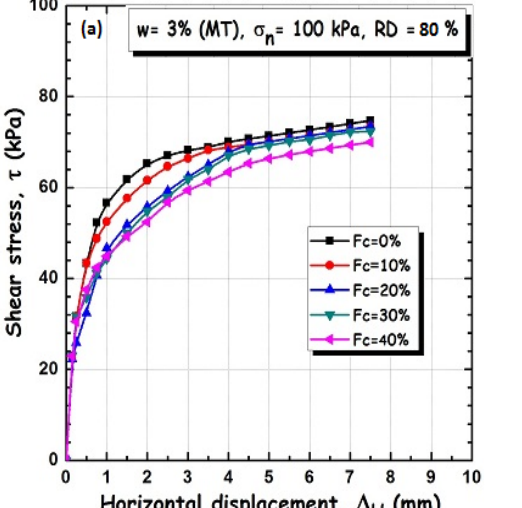
Figure 19: Effect of fines content on the mechanical behaviour of sand-silt mixtures (RD = 80%, σ strength versus horizontal displacement (w = 3%), (b) variation of the shear strength versus horizontal displacement (w =